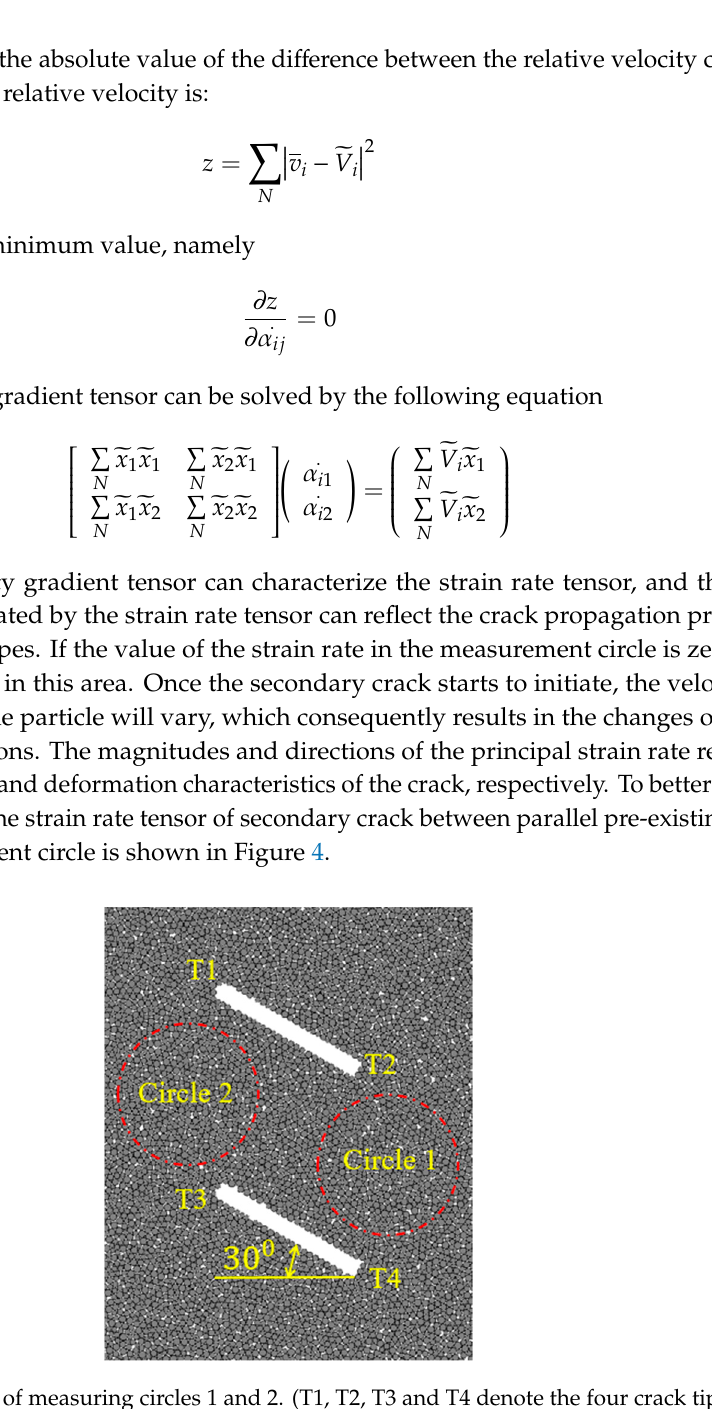
Figure 4. Layout of measuring circles 1 and 2. (T1, T2, T3 and T4 denote the four crack tips.).